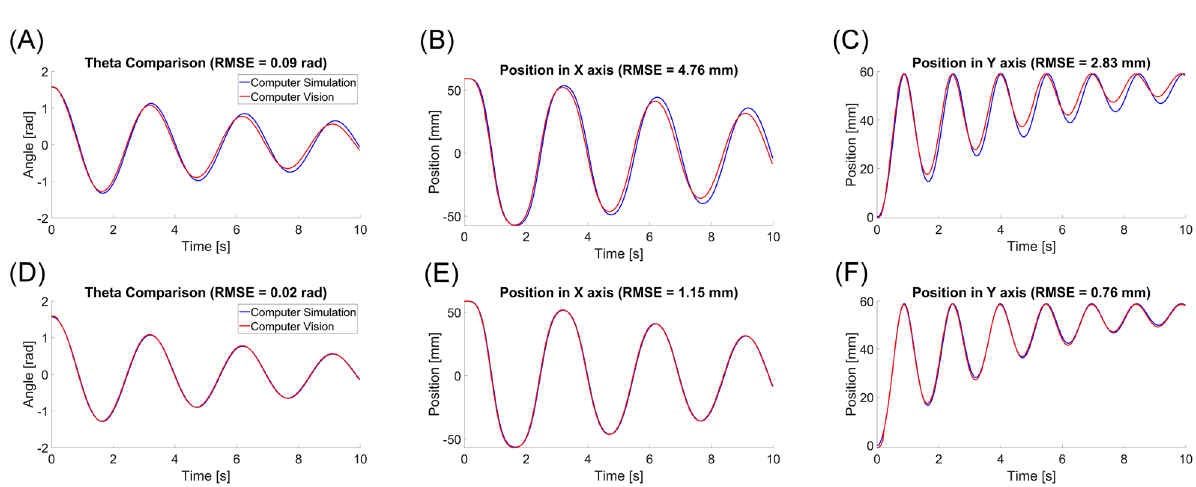
Figure 7. Experiment 2 results. ( A – C ) Data from 60 fps of frame rate. ( D – F ) Data from 120 fps of frame rate. ( A , D ) Pendulum angle comparison. ( B , E ) Position in x (mediolateral) direction comparison. ( C , F ) Position in y (superior-inferior) direction